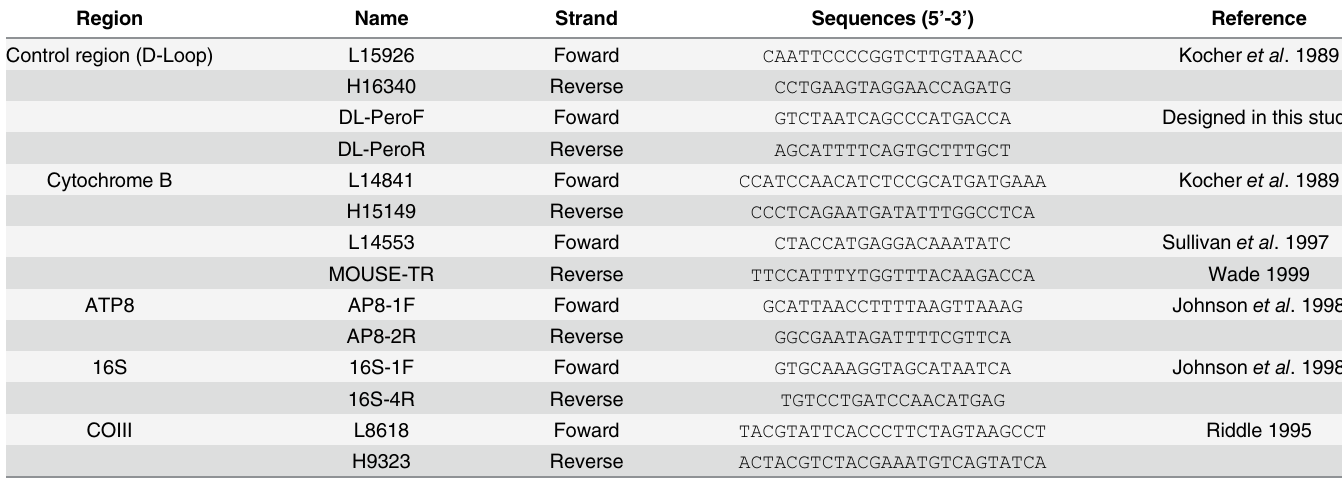
Table 2. Primers used for amplifying the five mtDNA regions used in this study.